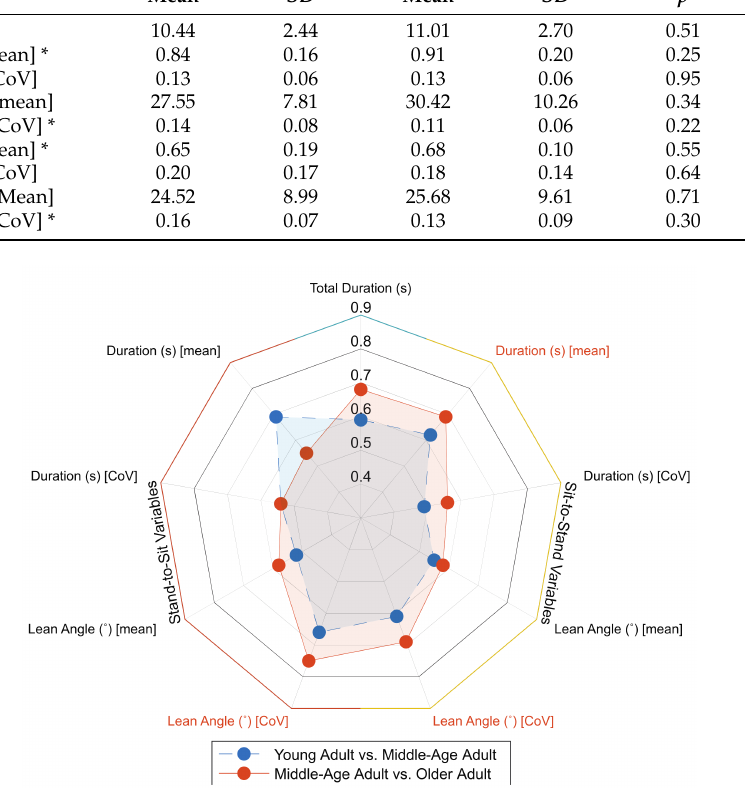
Figure 4. Spider plot representing all STS variables and their associated AUC values between groups. The variable names in color are those that were maintained in the stepwise regression for the group